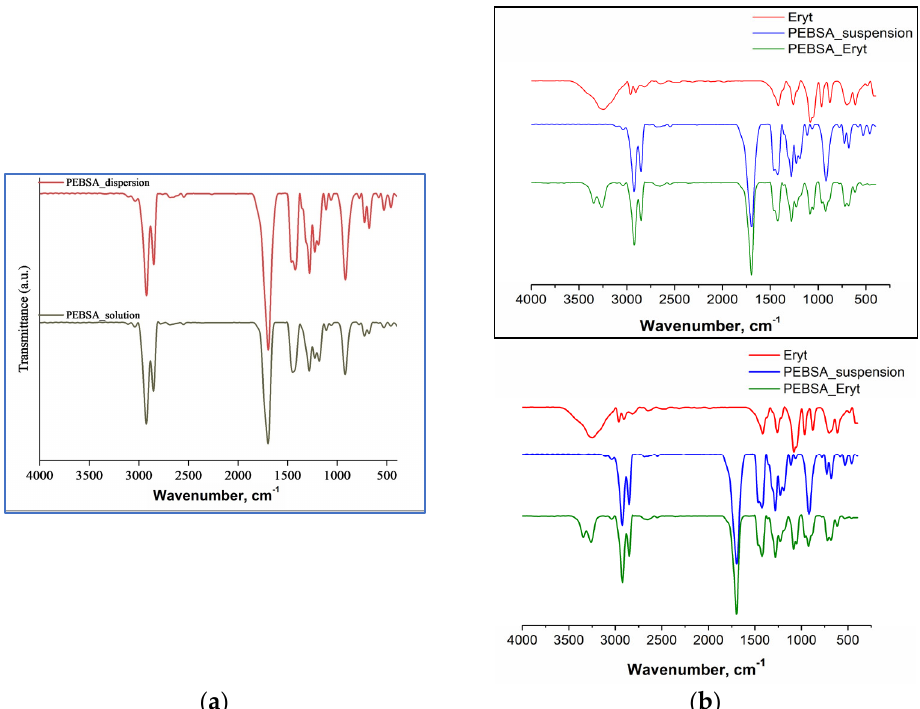
Figure 1. FTIR spectra of PEBSA_suspension and PEBSA_solution ( a ) and comparative PEBSA_Eryt samples ( b ).